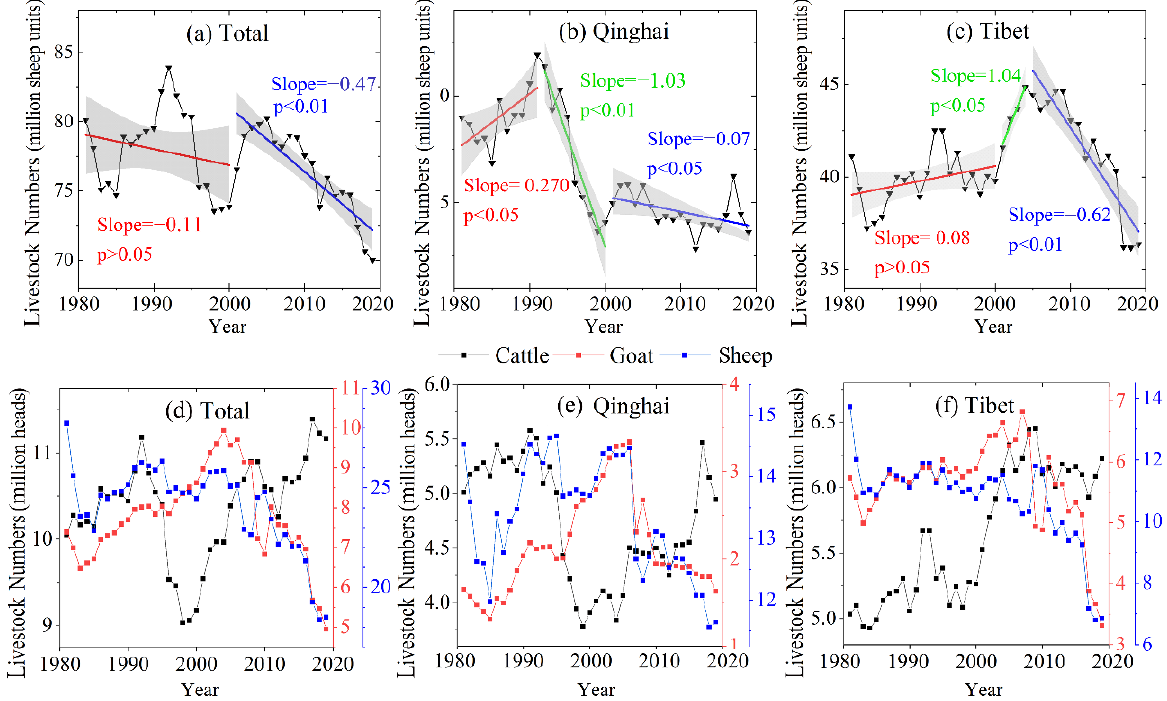
Figure 10. The trends in livestock population and by livestock type in the QTP, Qinghai, and Tibet.